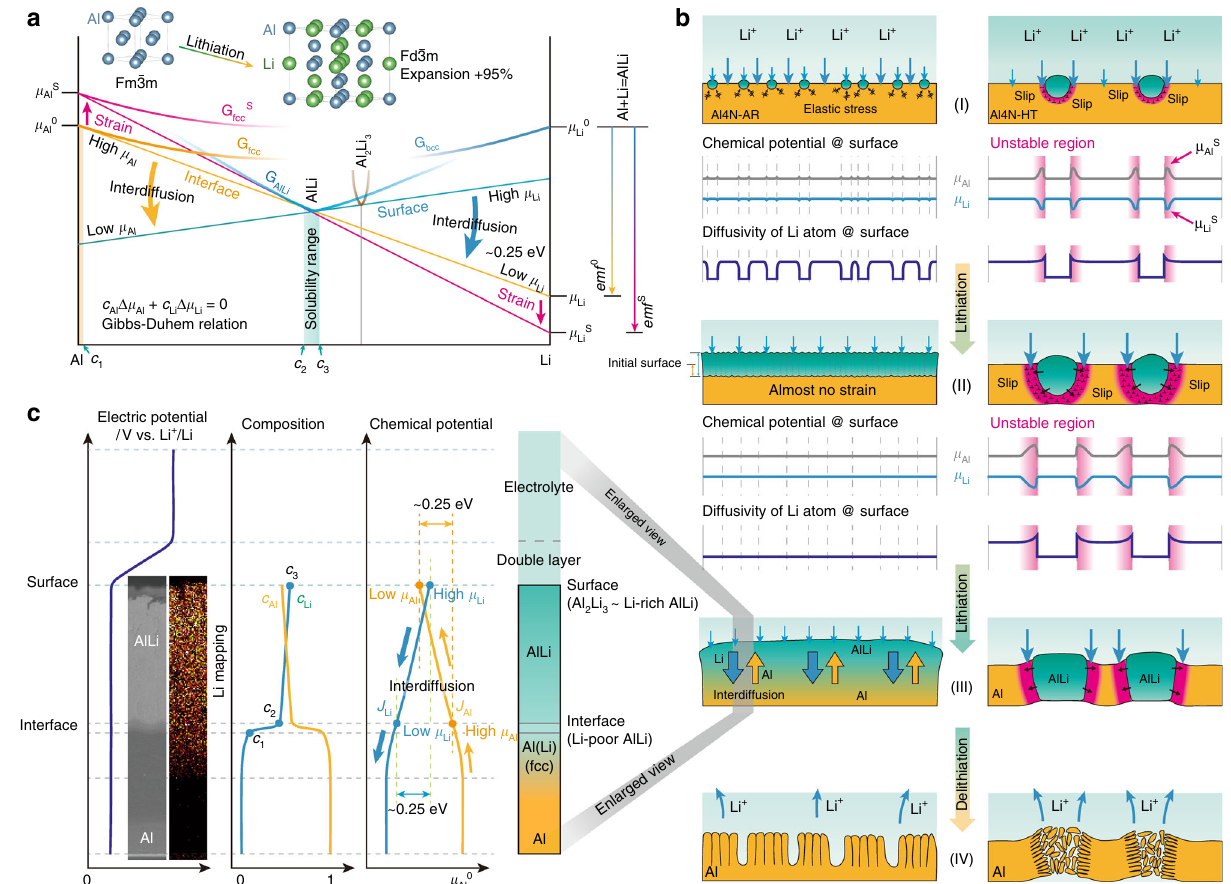
Fig. 3 Lithiation mechanism on an Al anode. a The Gibbs free-energy curves in Al-Li binary system. The two-phase reaction of fcc-Al/AlLi Li-poor (whose Li composition is C 2 ) occurs during lithiation. The chemical driving force of fcc-Al/AlLi reaction (~ emf 0 ) is about 0.38 eV (yellow line), but the value is enhanced when certain amount of strain energy is accumulated by mechanical deformation (pink line). Basically, the consideration of local equilibrium of fcc-Al/AlLi Li-poor is suf fi cient, but around the surface that of AlLi Li-rich /Al 2 Li 3 is also needed during lithiation. b Schematic illustration of the lithiation processes of mechanically hard and soft Al foils; (left) Al4N-AR and (right) Al4N-HT. Stages (I, II, III, and IV) corresponds to the SEM images in Fig. 2a; see also Supplementary Fig. 3. The appropriate hardness of Al4N-AR enables the homogeneous lithiation. As the diffusivity in the AlLi phase possessing an ordered lattice is generally slower than that in the fcc Al phase, the formation of AlLi in the remaining Al matrix is kinetically preferential, whereas the already deformed Al matrix tends to be preferentially attacked by Li thermodynamically. c Schematic pro fi les of gradients of electric potential, composition, and chemical potentials of Li and Al to illustrate the unidirectional volume-expansion mechanism during lithiation on Al4N-AR. Insets show the SEM image and SIMS mapping of Li at the ion-beam-fabricated cross-section of a partially lithiated Al4N-AR; full fi eld images are given in Supplementary Fig. 4. The chemical-potential gradients of Li and Al due to those of respective compositions drives the interdiffusion of Al and Li, whose maximum driving force is estimated to be about 0.25